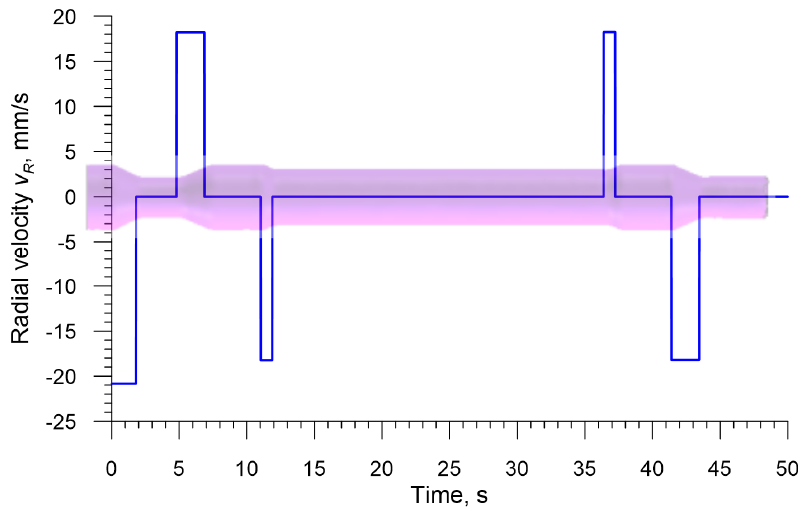
Figure 3. Radial velocity of the rolls, v R , used in the numerical analysis.